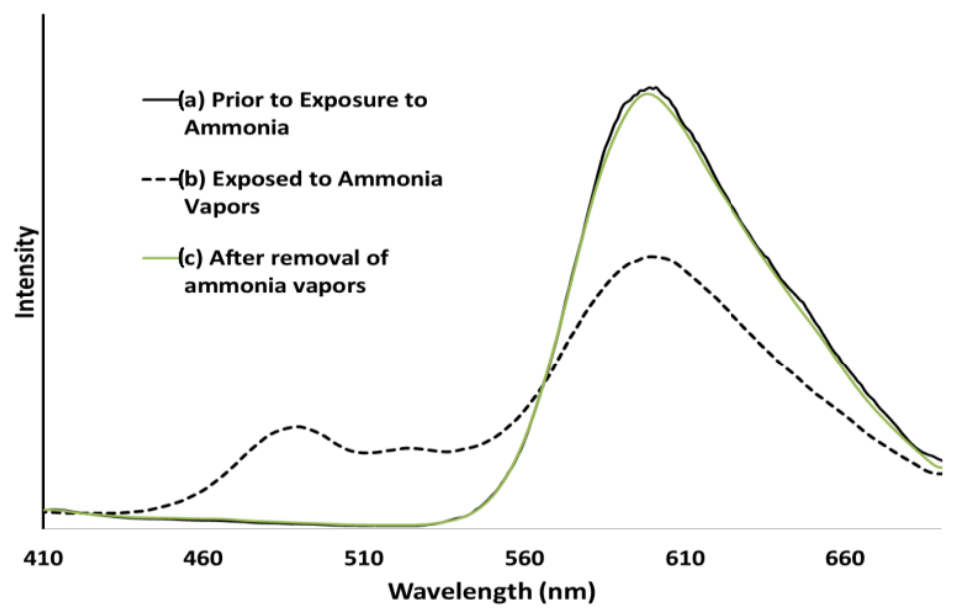
Figure 12. ( a ) Emission spectra of a P9BFV film before exposure to NH 3 vapors, ( b ) emission spectra of a P9BFV film while being exposed to NH 3 from aqueous ammonium hydroxide, ( c ) emission spectra of a P9BFV film 5 min after removal of the NH 3 source and NH 3 vapors. Reproduced with permission from reference [95]. Copyright 2015, John Wiley and Sons.